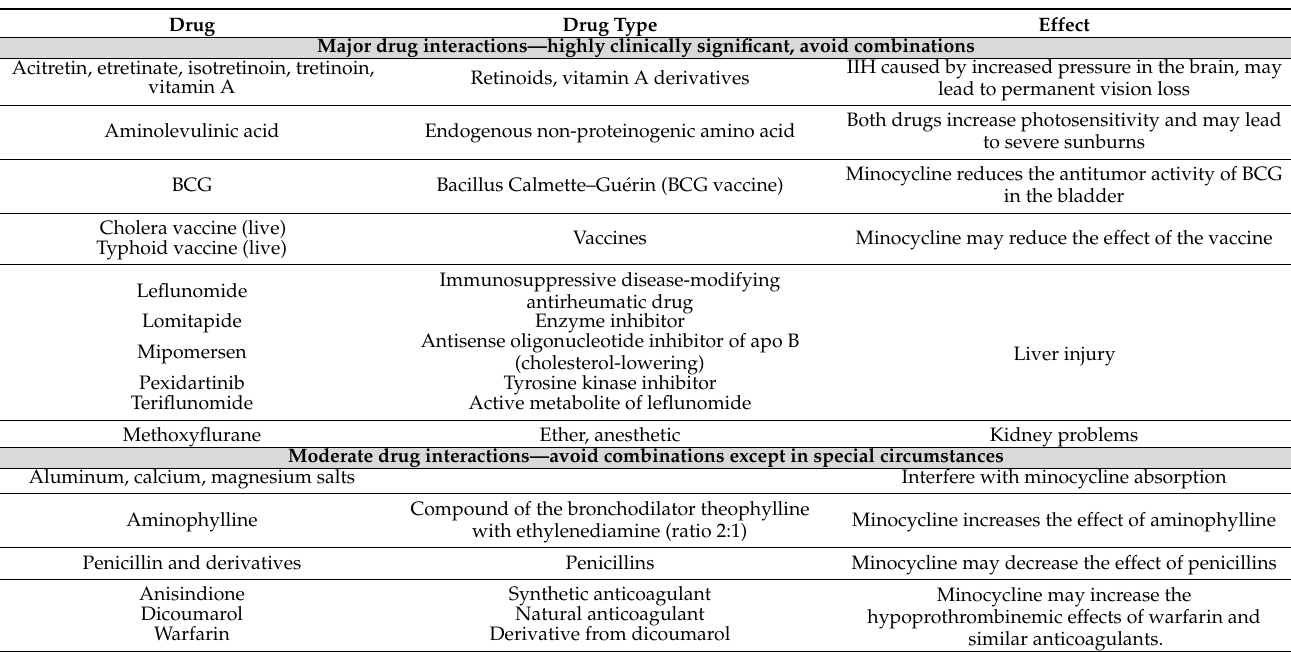
Table 3. Interactions of minocycline with other drugs